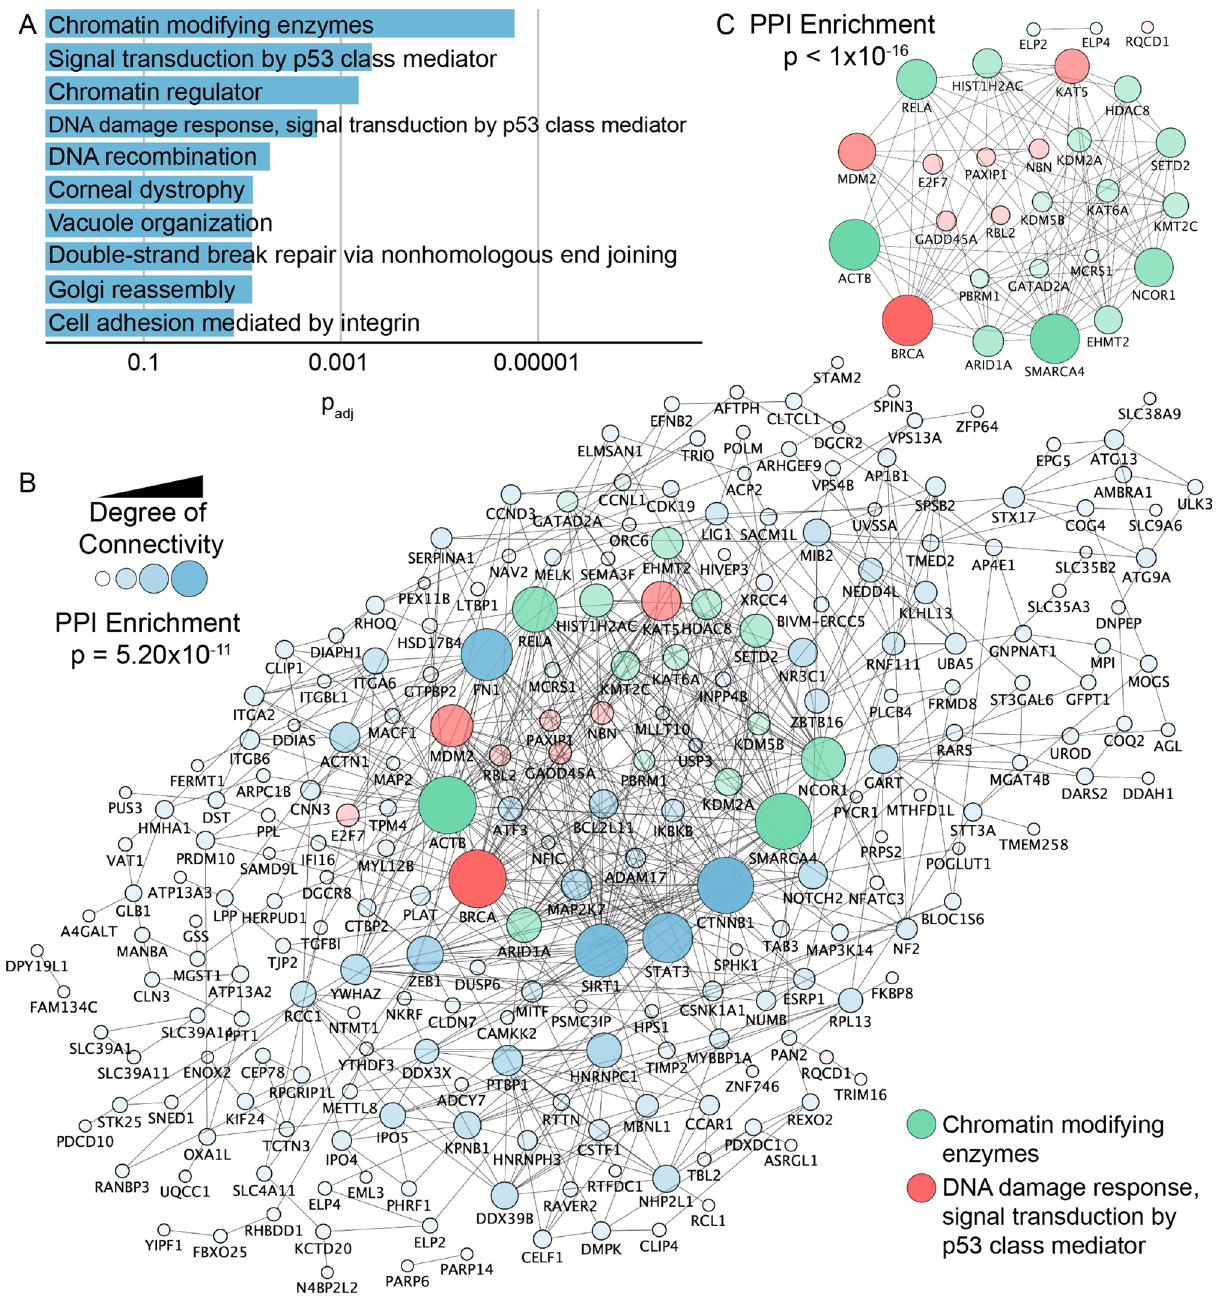
Figure 3. Functional analysis of 8-oxoG enriched transcripts shows RNA oxidation in chromatin regulation and DNA-damage repair transcripts. ( A ) Functional pathway analysis and GO associated terms identified by StringApp in Cytoscape based on transcripts enriched in oxidation following formaldehyde exposure of BEAS-2B cells (p adj < 0.05). Redundant pathways were removed for clarity. Individual transcripts associated with each pathway are described in Data S2. ( B ) STRING-DB analysis of gene products from oxidation enriched transcripts shows significantly more interactions than expected due to chance (p = 5.20 × 10 –11 ) following exposure to 1 ppm formaldehyde. ( C ) Gene products from the oxidation enriched set that belong to the chromatin modifying enzymes (green shade), and to the DNA damage response, signal transduction by p53 class mediator (red shade) share a high degree of connectivity in the protein–protein interaction network (p < 1 × 10 –16 ). Larger node size and darker fill shade indicate higher